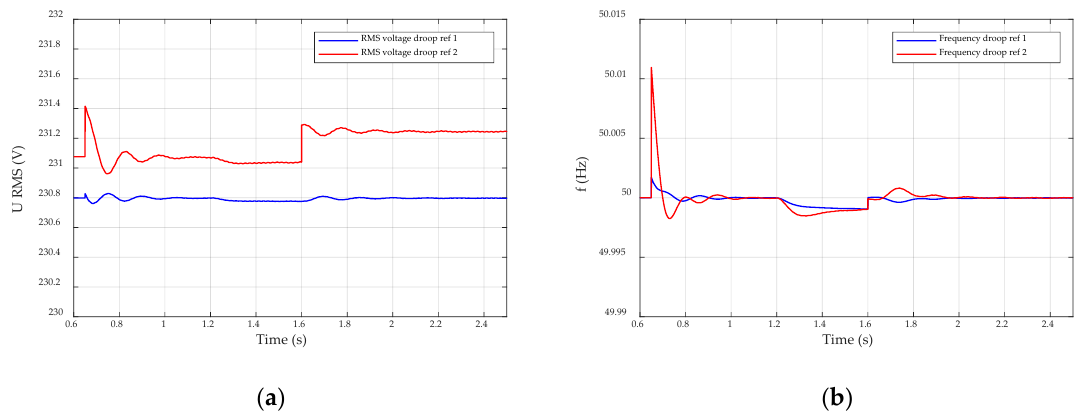
Figure 8. Droop control performance: ( a ) Voltage droop reference in the filter capacitor; and, ( b ) Frequency droop reference.